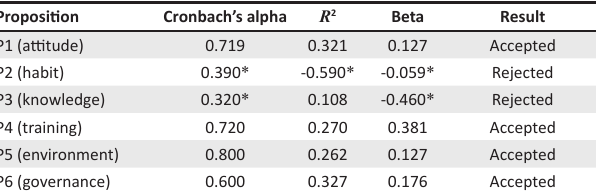
TABLE 6: Evaluation of research propositions.